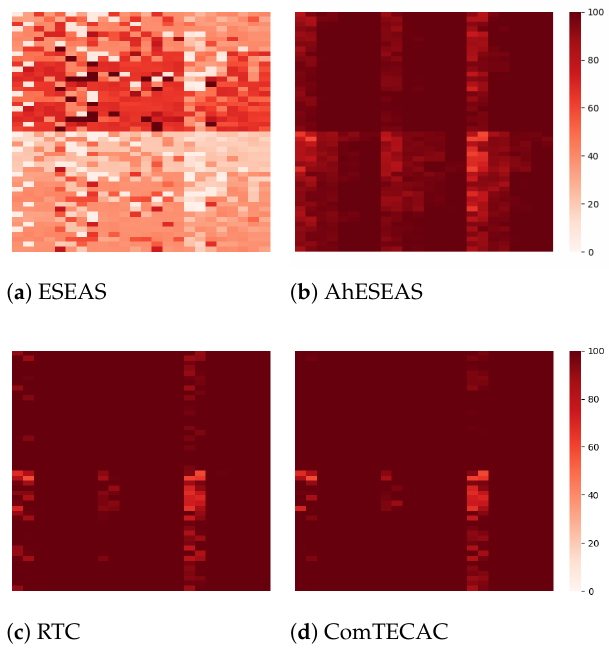
Figure 5. Recent clusters completed jobs (dark is